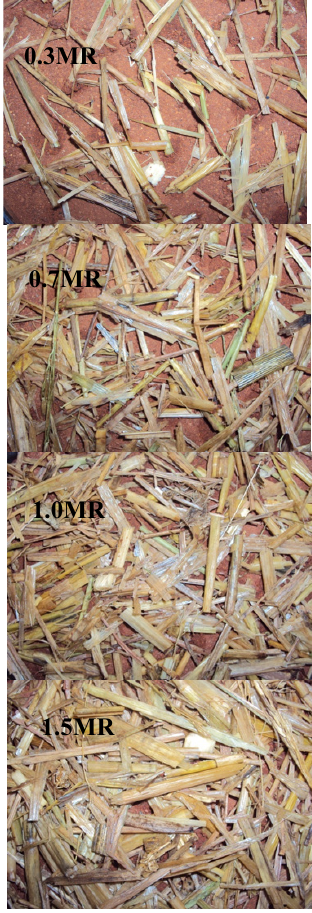
Figure 2 Zoomed view of crop residue cover